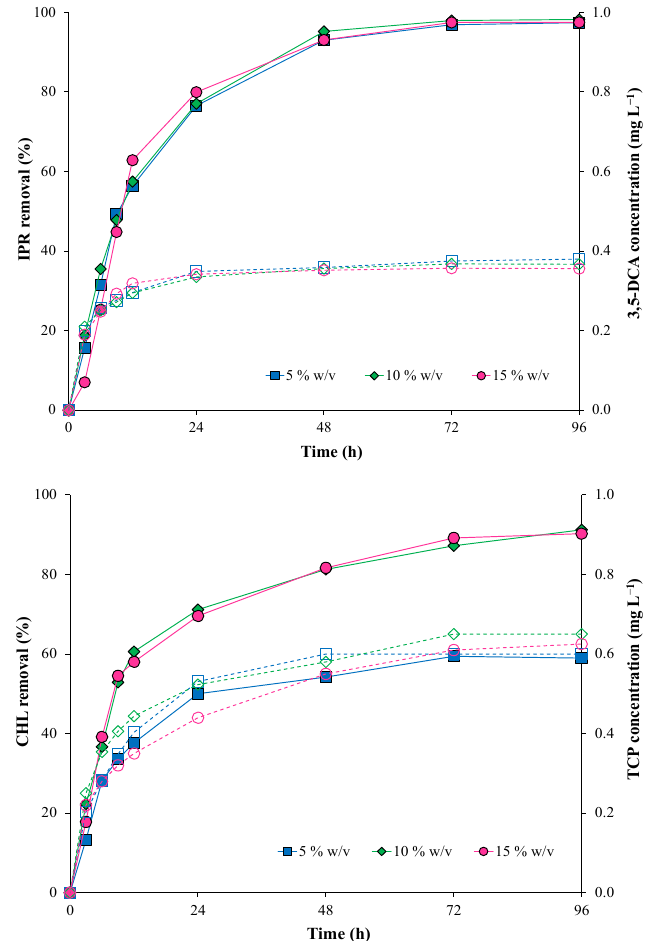
Figure 4. Pesticide removal (symbol filled with continuous line) and metabolite production (empty symbol with a dotted line) with the immobilized bacterial consortium at different inoculum concen- trations (5, 10, and 15% w/v ). Iprodione (IPR) and chlorpyrifos (CHL) were added (in mixture) at an initial concentration of 50 mg L − 1 each. Table 3. First-order kinetics parameters for iprodione (IPR) and chlorpyrifos (CHL) removal at a concentration of 50 mg L − 1 each, inoculated with the immobilized bacterial consortium at different inoculum concentrations (5, 10, and 15% w/v ).